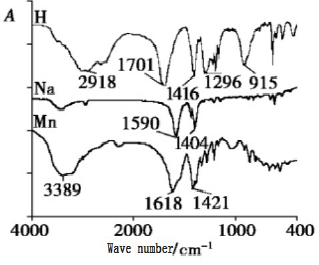
Figure 2. Thermogravimetric curves.